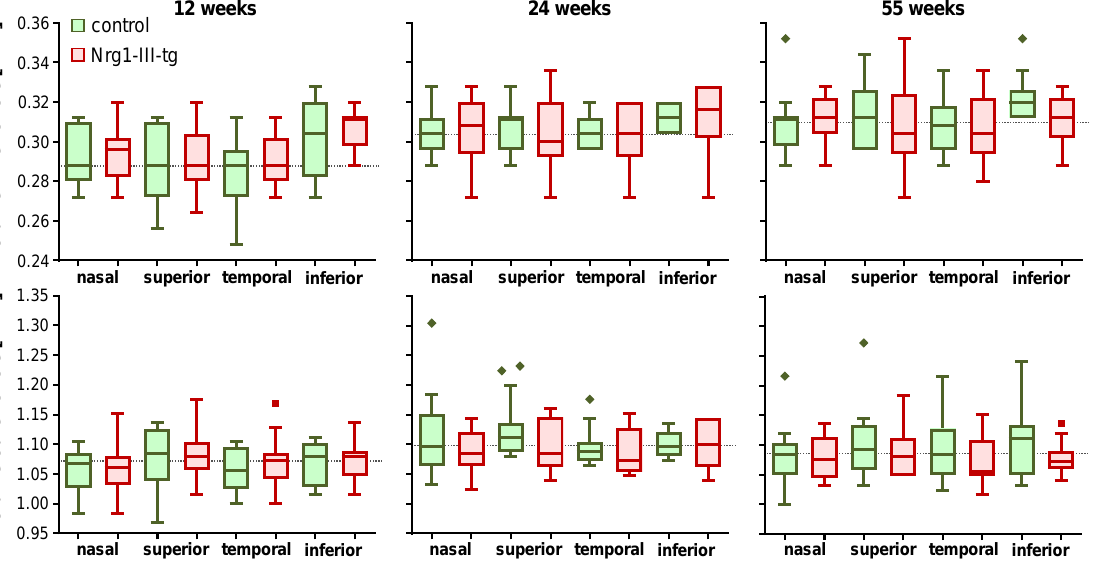
Figure 4. The Volume of retina in 12-, 24- and 55-week-old mice. Data are shown as mean values. Error bars show standard error of means. Number of animals at the age of 12, 24 and 55 weeks: n = 12, n = 13 and n = 14 control mice and n = 16, n = 8 and n = 10 Nrg1-III-tg age-matched mice, respec- tively.